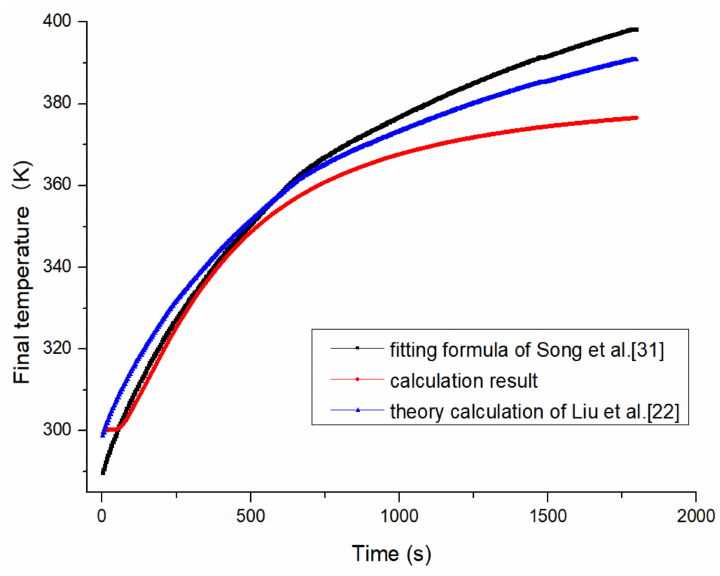
Figure 8. Final temperature during the time with different